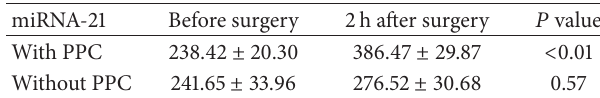
Table 6: miRNA-21 expression level according to PPCs. miRNA-21 Before surgery 2 h after surgery 𝑃 value With PPC Without